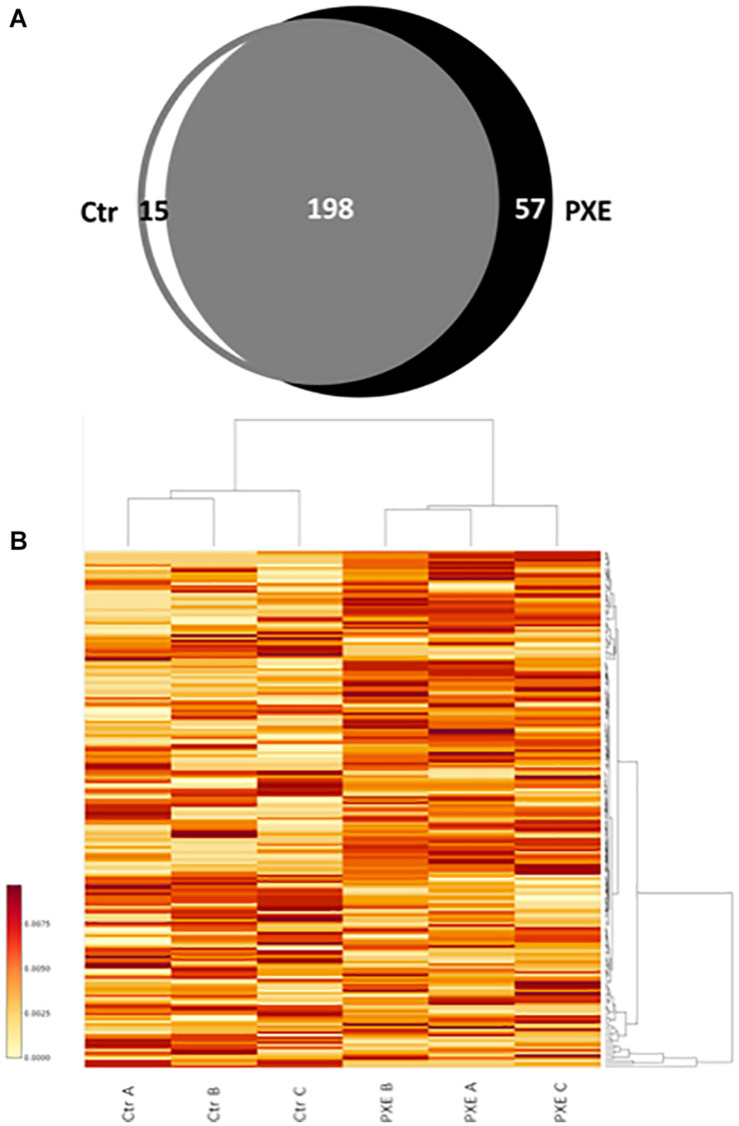
(A) Venn diagram of identified proteins referred to as mitochondrial proteins in control (Ctr) and Pseudoxanthoma elasticum (PXE) fibroblasts. (B) Heat map of relative abundance of differentially expressed mitochondrial proteins in a pool of three Ctr and of three PXE samples. Three independent experiments (A, B, and C biological replicates) were performed in duplicate (technical replicates). The colored bar indicates the expression levels.